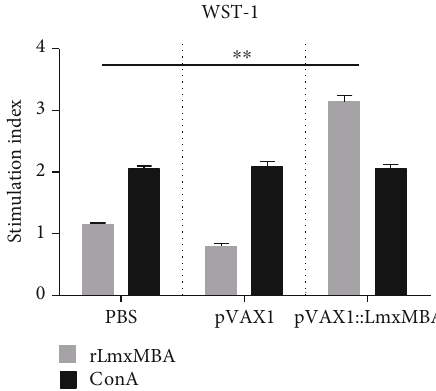
Figure 6: Proliferation of mononuclear cells in the spleen of mice immunized with PBS, pVAX1, or pVAX1::LmxMBA after stimulation with rLmxMBA. The mean stimulation index (SI) of vaccinated mice (injected with pVAX1::LmxMBA) was nearly 3 times greater than the mean SI of control mice (injected with PBS or pVAX1). ConA: concanavalin A. ∗ p < 0 : 05